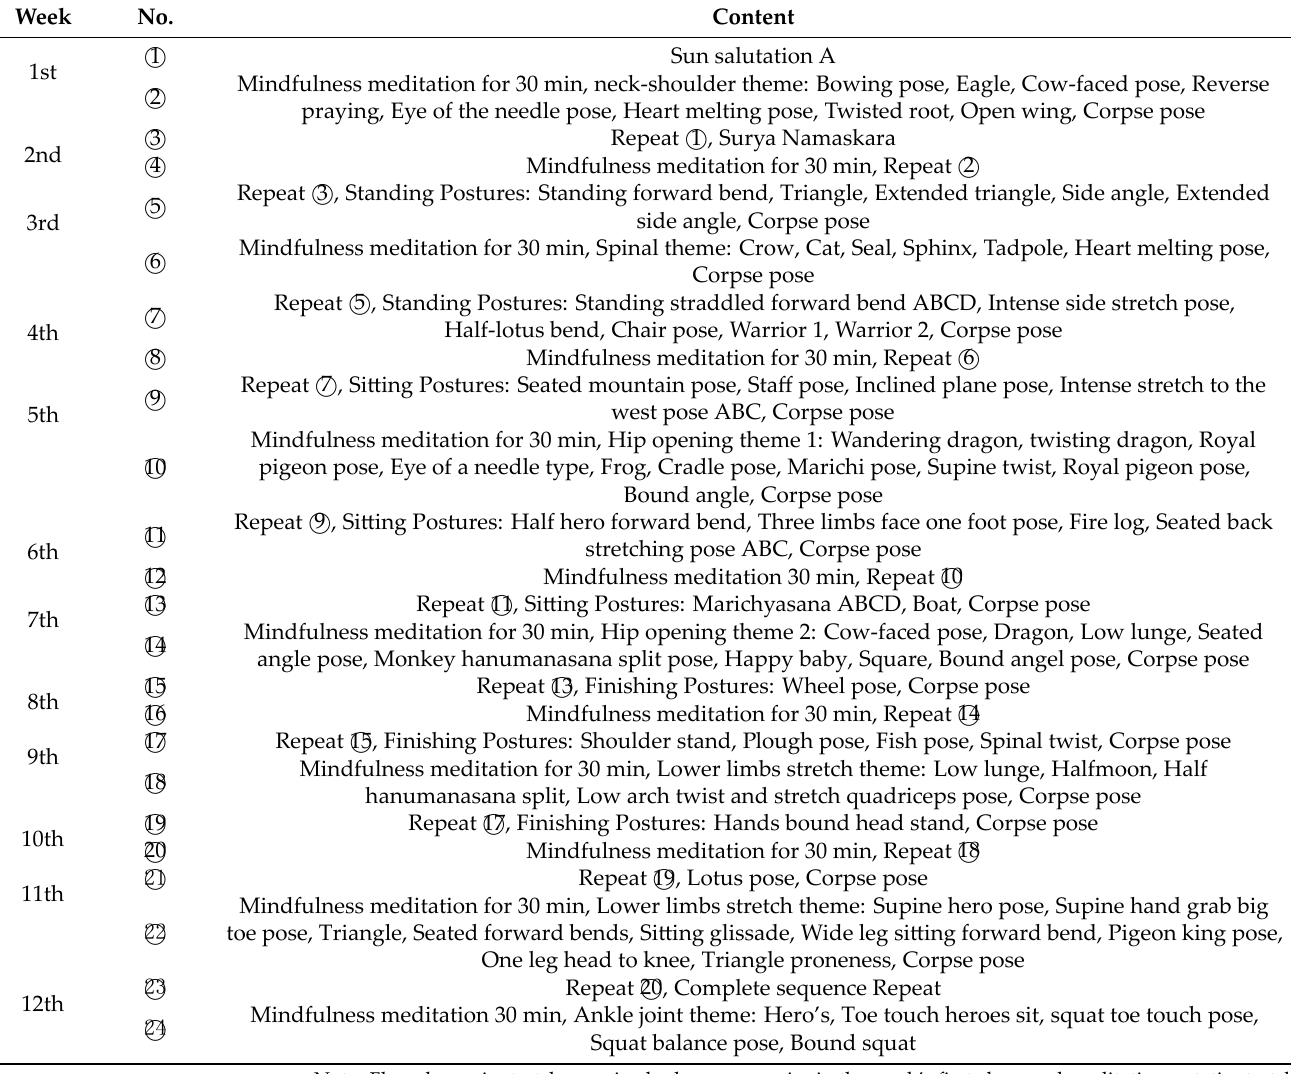
Table 3. Yoga intervention